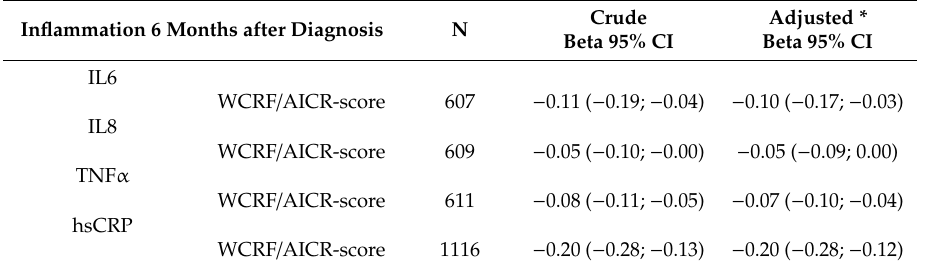
Table 2. The association between lifestyle at diagnosis and inflammatory marker levels six months after diagnosis in colorectal cancer patients.